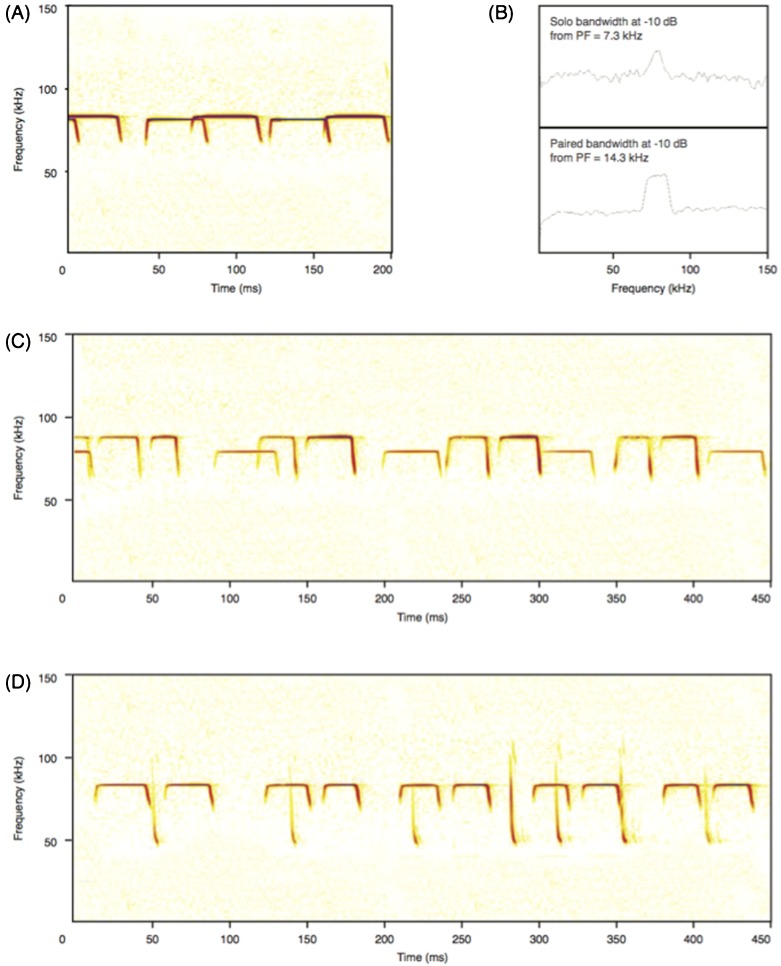
Echolocation calls.(A) R. capensis flying in a conspecific pair in the large flight room. (B) Power spectra (fast Fourier transforms) of FMt for R. capensis flying alone (top panel) and flying in a conspecific pair (bottom panel), both in the large flight room. (C) R. capensis flying with R. clivosus in the large flight room. (D) R. capensis flying with M. natalensis in the large flight room.